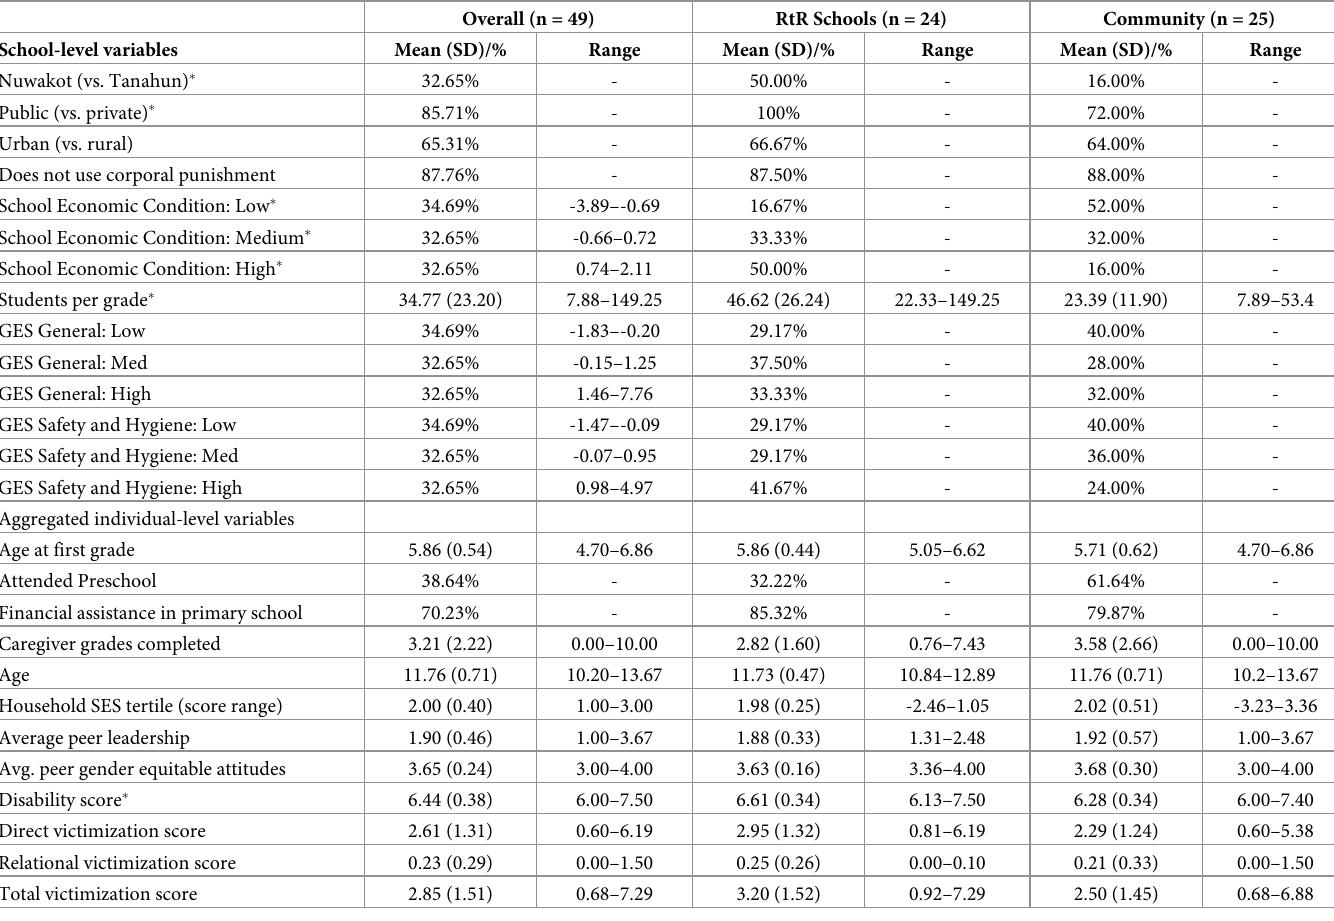
Table 3. Characteristics of schools, community sample (N = 25) and RtR school sample (N = 24), Nuwakot and Tanaun districts, Nepal